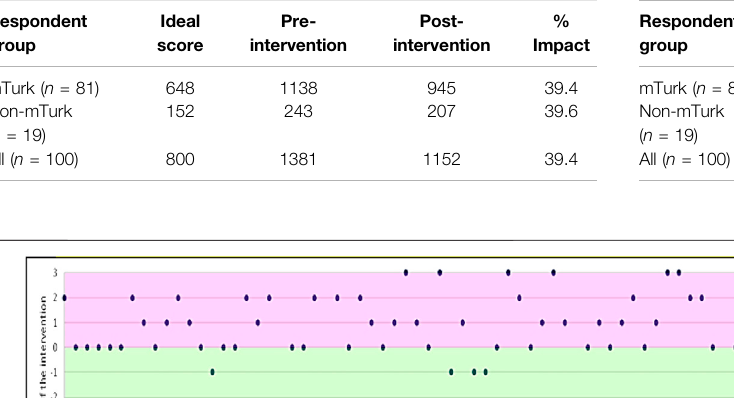
TABLE 4 | Percentage impact of the intervention on